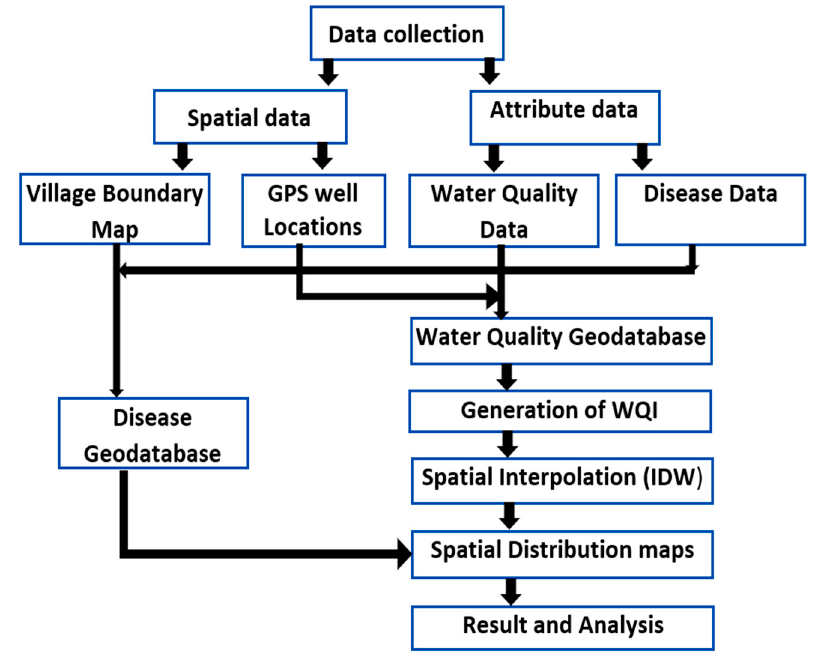
Figure 3. Research methodology flowchart.